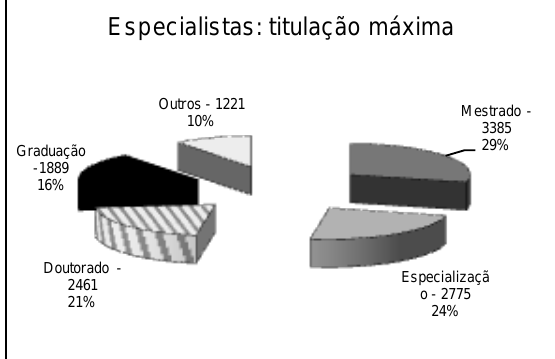
Figura 9. Especialistas: titulação máxima. Fonte: Portal da Inovação. Acesso em: